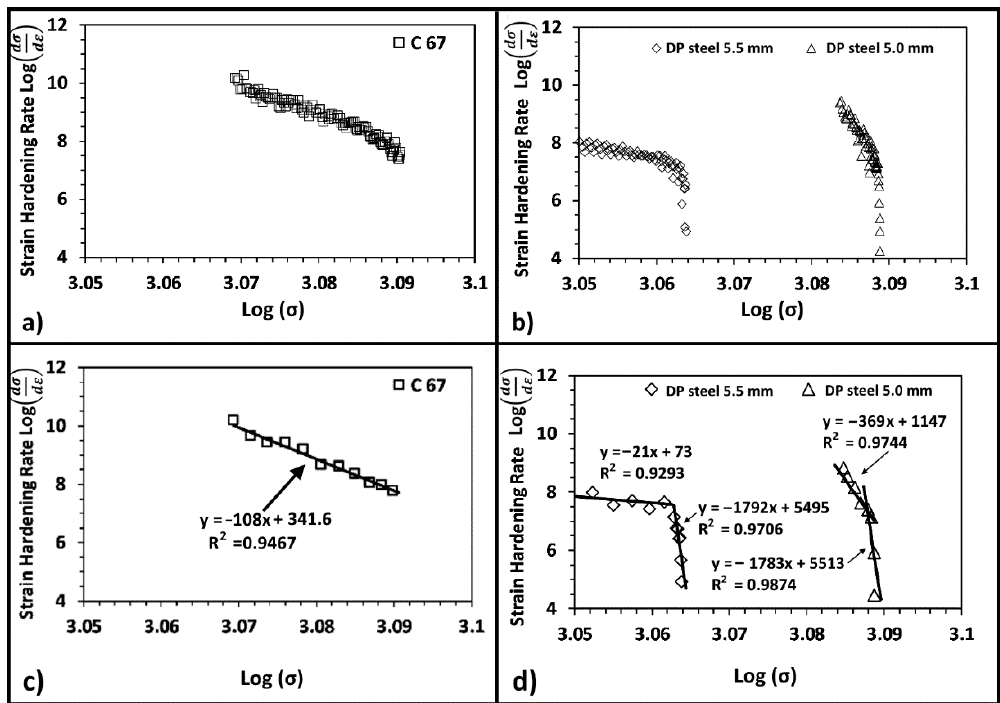
Figure 12. Strain-hardening curve for C67 ( a ) and for DP steel ( b ); all experimental data are shown. Same plots but with fewer experimental points for better representation ( c , d ).